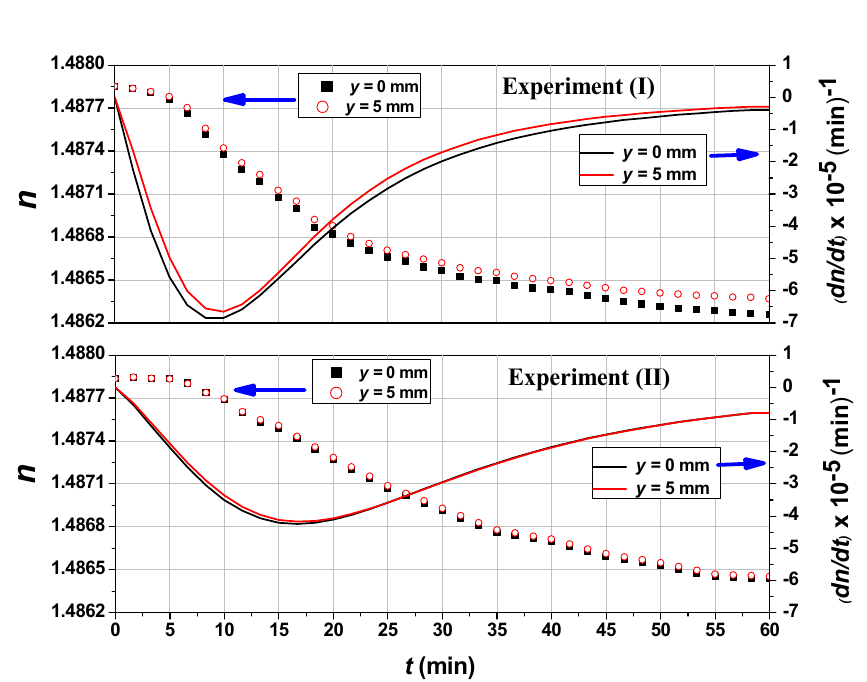
Figure 8. Temporal refractive index profiles of toluene for the points y = 0 mm and y = 5 mm for the two cases of UV 254